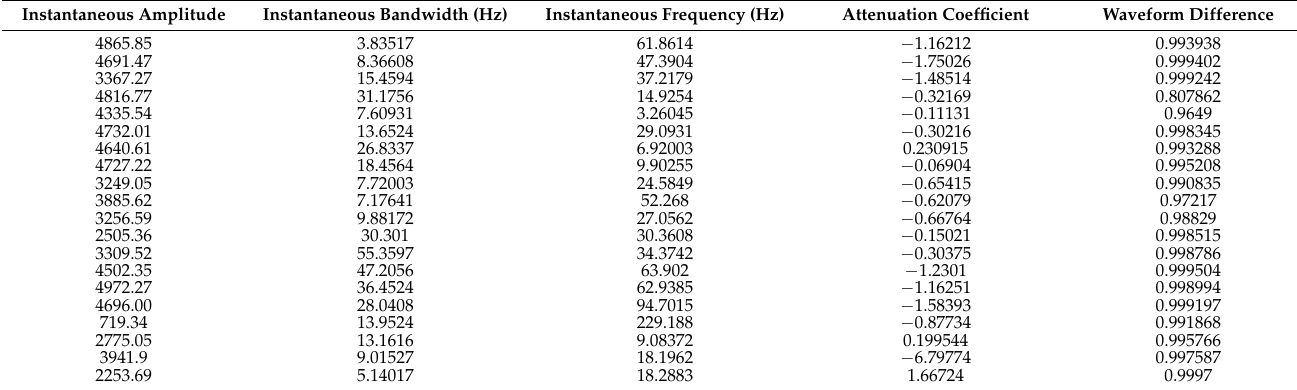
Table 2. Partial seismic attribute samples for support vector machine learning